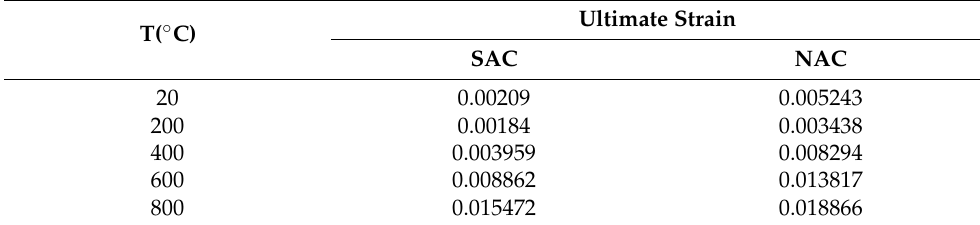
Table 4. Ultimate strain of concrete after different temperatures.